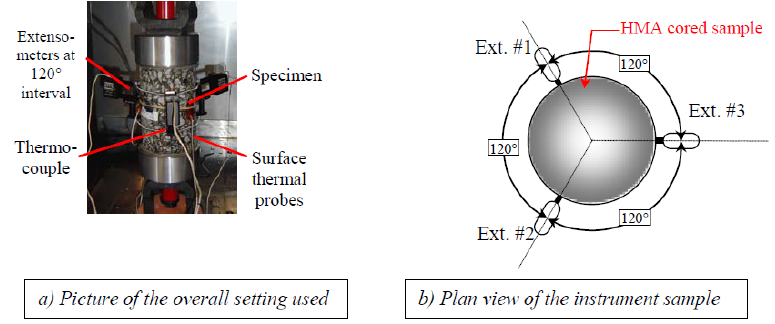
Figure 11. Schematics of the test setup used in this study.